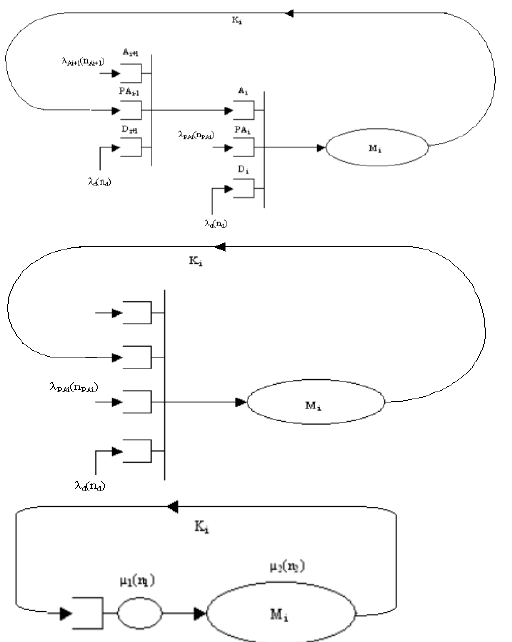
Figure 5. Equivalent scheme of a one stage Extended Kanban